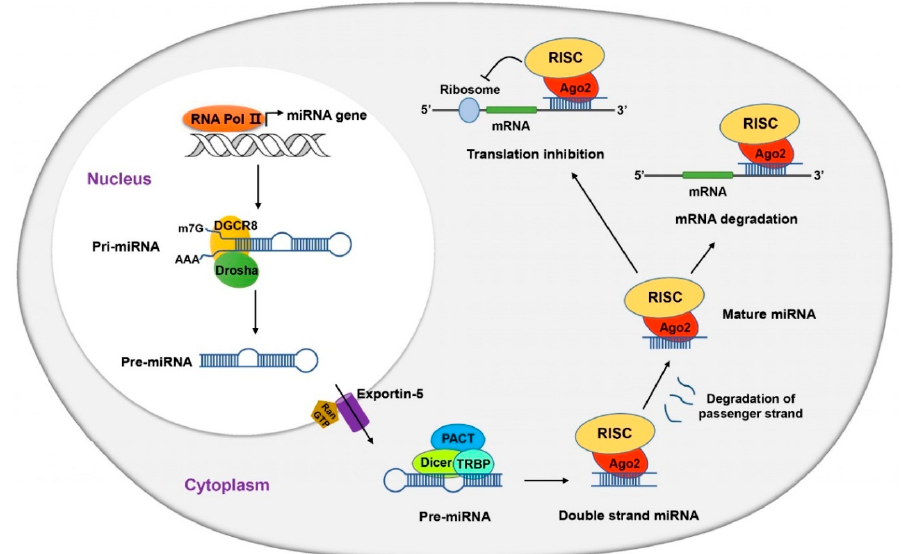
Figure 3. Biogenesis of miRNA. Please refer to the main text for details. RNA Pol II: RNA Polymerase II; Pri-miRNA: Primary-miRNA; Pre-miRNA: Precursor-miRNA; DGCR8: DiGeorge syndrome critical region gene 8; Drosha: Ribonuclease Type III; Dicer: RNase III endonuclease; PACT: protein activator of the interferon induced protein kinase; TRBP: TAR RNA binding protein; RISC: RNA induced silencing complex; Ago2: Argonaute 2.